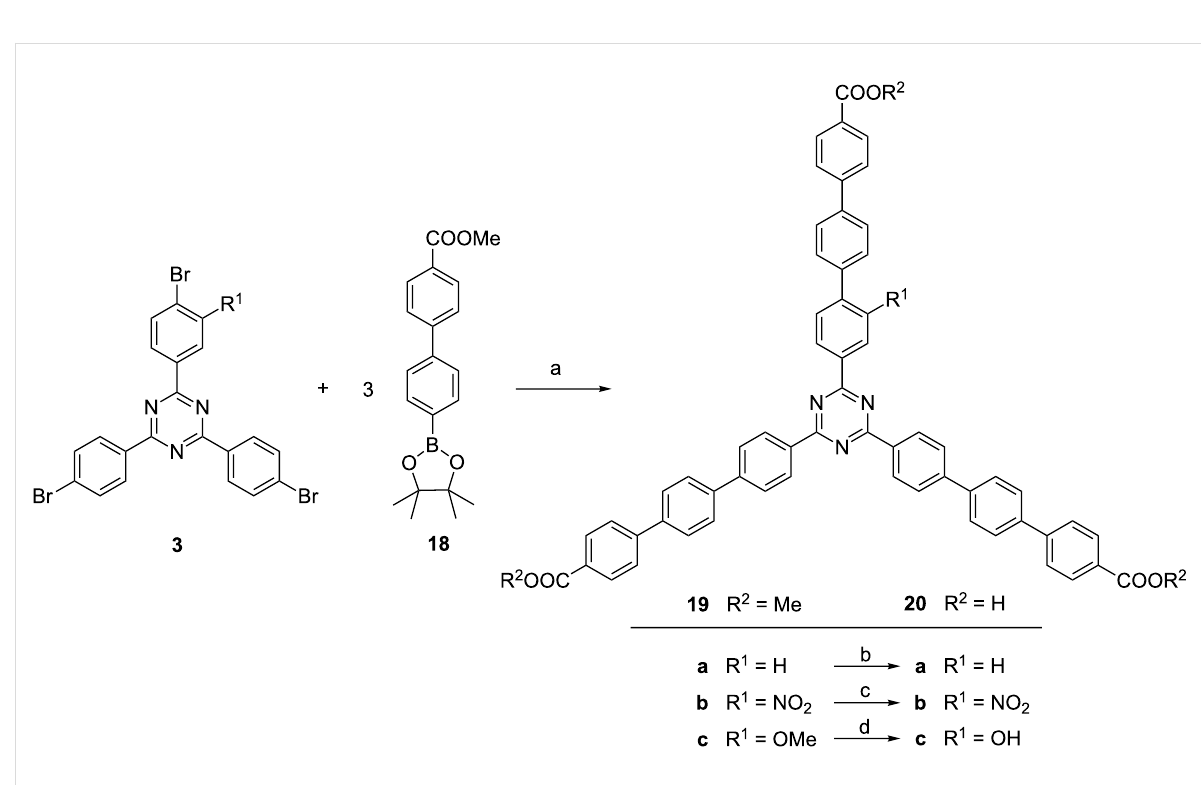
Figure 8: Triple Suzuki coupling between tribromotriazines 3 and boronate 18 . Conditions: a) 19a : Pd(PPh 3 ) 4 , K 3 PO 4 , dioxane/H 2 O, 2 d, 120 °C, 24%; 19b : Pd(dppf)Cl 2 , K 3 PO 4 , dioxane/H 2 O, 3 d, 120 °C, 16%; 19c : Pd(PPh 3 ) 4 , K 3 PO 4 , dioxane/H 2 O, 2 d, 100 °C, 81%; b) LiOH/H 2 O/THF, 24 h, 120 °C, 20a : 99%; c) NaOH/H 2 O/dioxane, 24 h, 120 °C, 20b : 79%; d) pyridinium hydrochloride, 12 h, 200 °C, 20e :